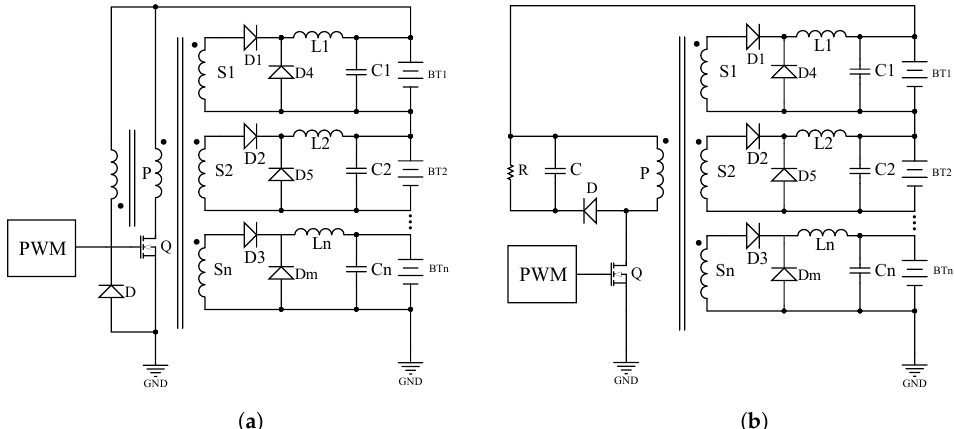
Figure 1. ( a ) Schematic of the forward converter circuit with reset winding; ( b ) schematic of the RCDforward converter circuit.